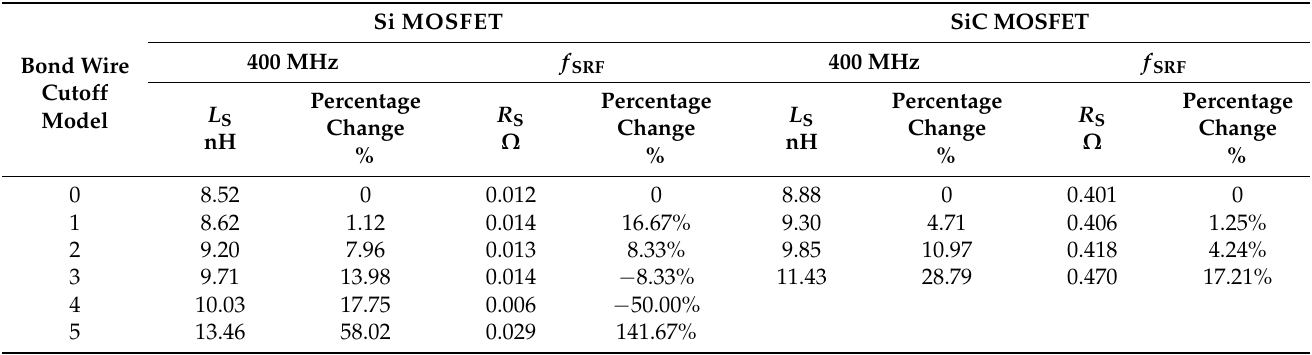
Figure 14. L S_C2 of C2M0160120D with different cutoff numbers of bond wires. Table 4. Parasitic inductance and resistance with different cutoff numbers of bond